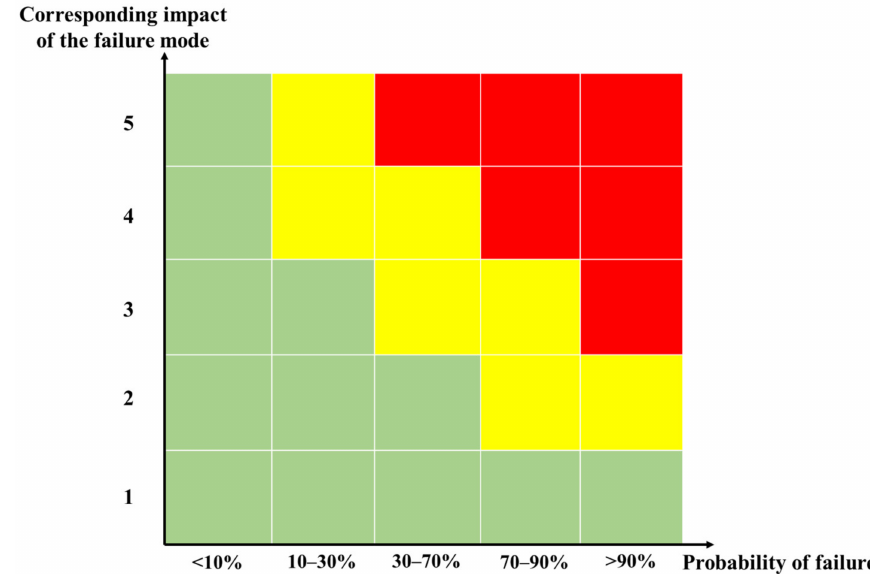
Figure 1. An example of the risk matrix.